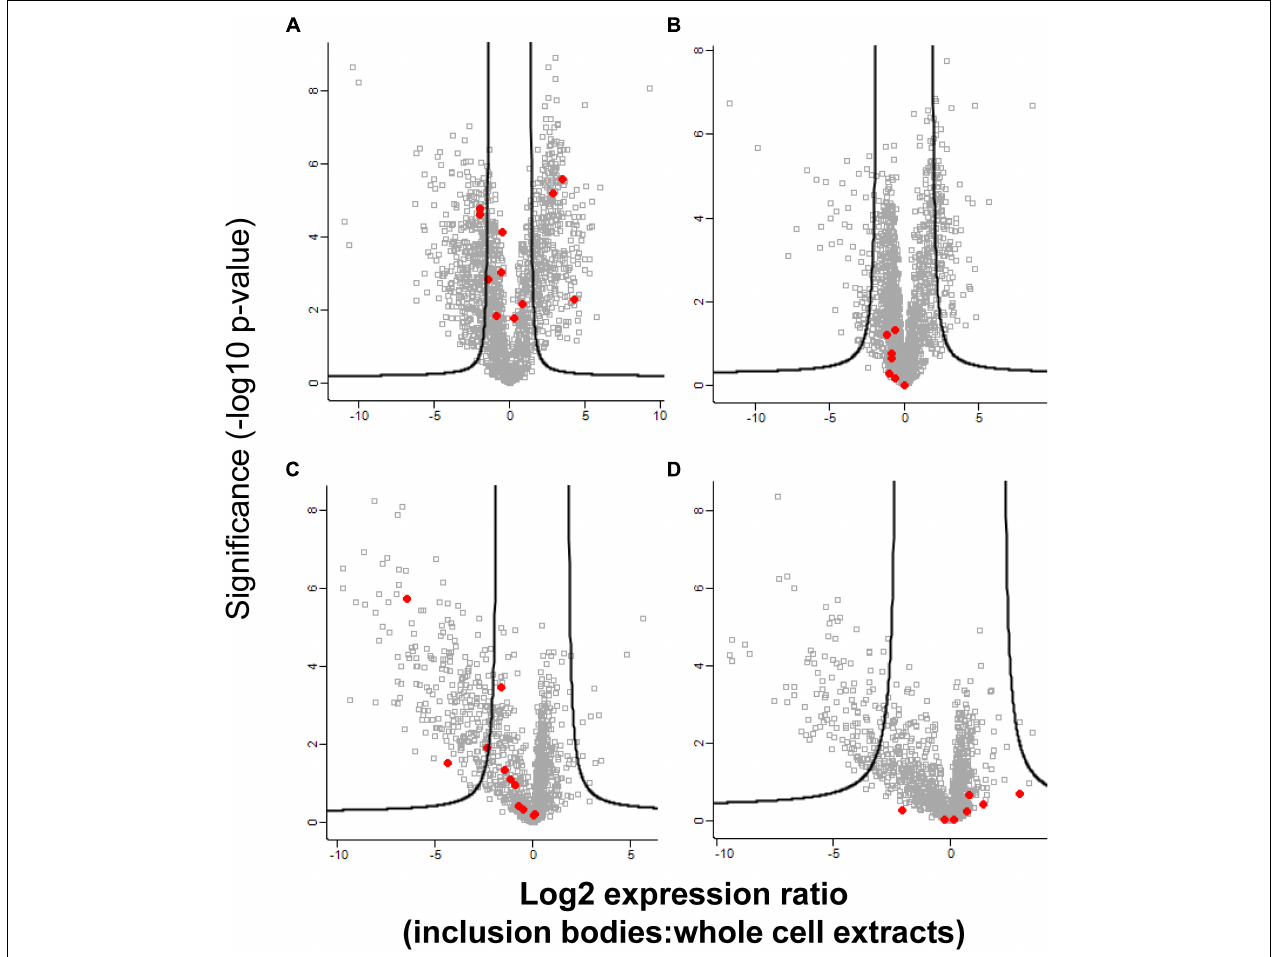
FIGURE 4 | Abundance of proteins in inclusion bodies and whole cell extracts in E. coli MG1655 ibpA-yfp in inclusion bodies and whole cell extracts, with and without treatment with 400 MPa for 3 min. Shown is the log 2 transformed ratio of the protein abundance in inclusion bodies relative to the abundance in whole cell extracts obtained from the same sample. (A) Expression ratio of untreated E. coli MG1655 ibpA-yfp (pLHR); (B) expression ratio in untreated E. coli MG1655 ibpA-yfp (pRK767); (C) expression ratio in E. coli MG1655 ibpA-yfp (pLHR) after treatment at 400 MPa; (D) expression ratio in E. coli MG1655 ibpA-yfp (pRK767) after treatment at 400 MPa. The level of significance was evaluated using a two-sided unpaired student’s t -test and p -values were corrected for multiple testing using a permutation based 1% FDR cutoff and the sample background variability s0. Red dots: proteins expressed by the LHR, other proteins are indicated by gray squares. Note that the x -axes for untreated cell (A,B) and for pressure treated cells (C,D) are scaled differently. Proteome analyses were performed in quadruplicate independent experiments with technical repeats for each sample.